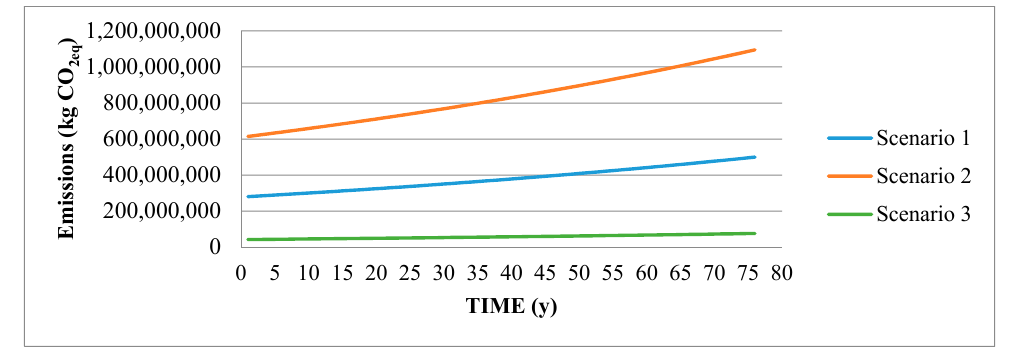
Figure 7. Long term emission savings probabilities of replacing gasoline with ethanol from forest biomass in Michigan.